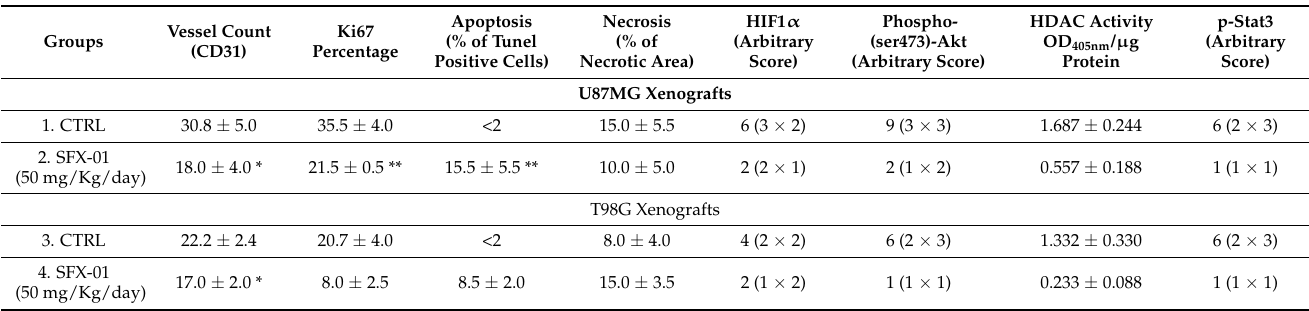
Table 2. Immuno-histochemical and enzymatic evaluation on markers of proliferation, apoptosis, autophagy, angiogenesis, stemness and signaling in untreated (control) and treated with SFX-01 in U87MG and T98G xenografts.